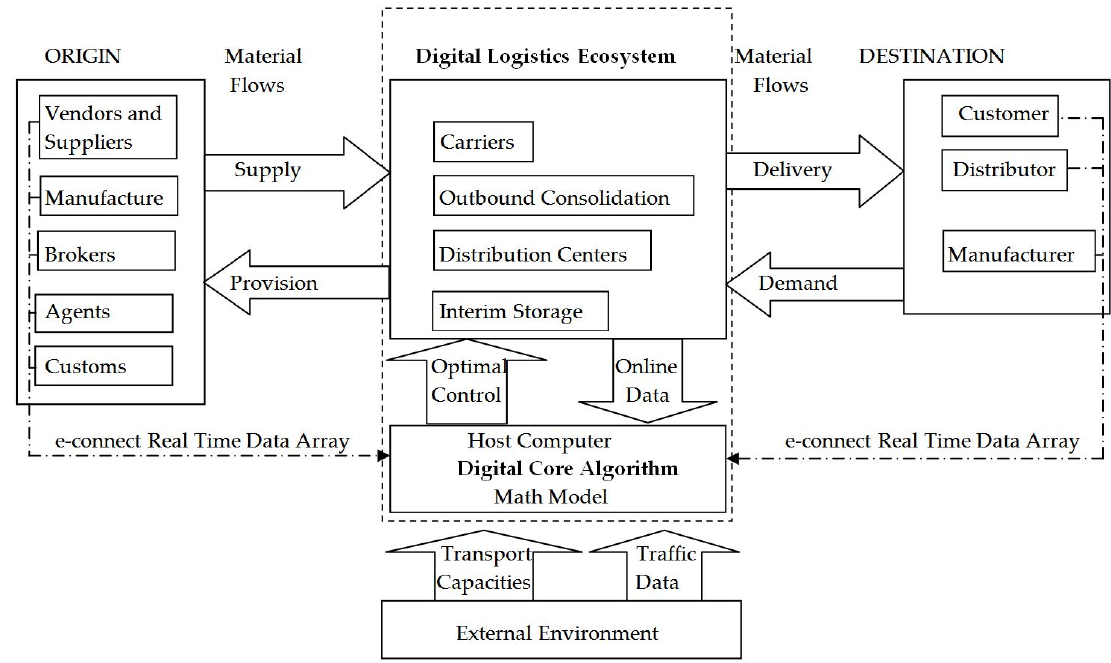
Figure 2. Model of digital logistics processes.